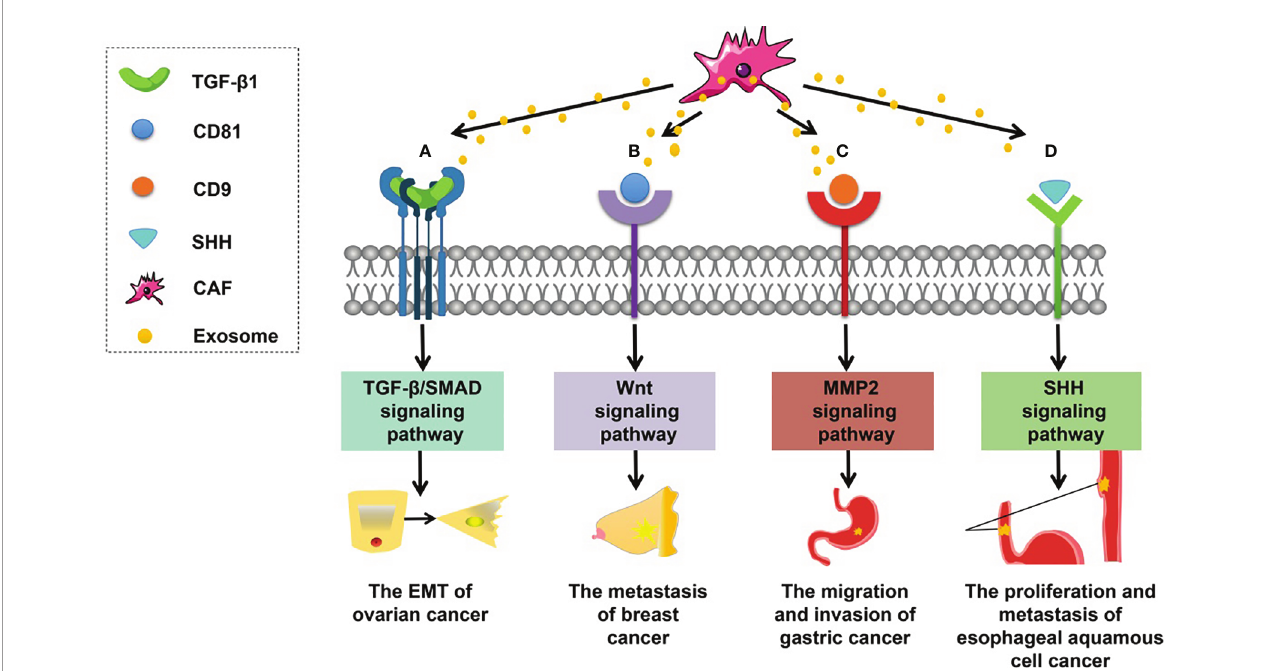
FIGURE 2 | Roles of CAF-derived exosomal proteins in tumorigenesis. (A) CAF-derived exosomal TGF- b can activate the TGF- b – SMAD signaling pathway to promote EMT in ovarian cancer. (B) CAF-derived exosomal CD81 can trigger the WNT signaling cascade contributing to the metastasis of breast cancer. (C) CAF- derived exosomal CD9 can activate MMP2 signaling enhancing the migration and invasiveness of gastric cancer cells. (D) CAF-derived exosomal SHH can launch the SHH signaling pathway thus increasing the proliferation and metastasis of esophageal squamous cell cancer (ESCC)